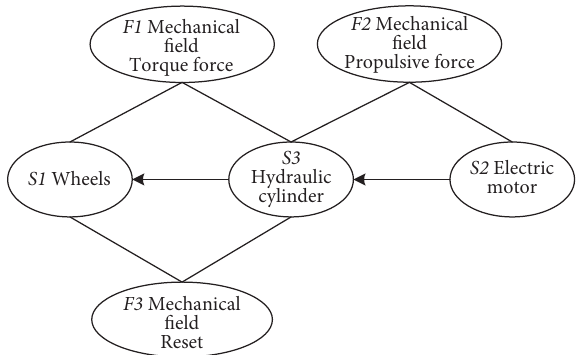
Figure 7: The substance-field model of hydraulic